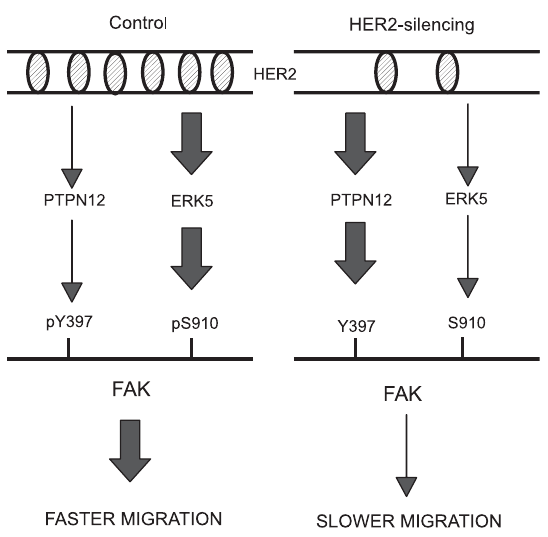
Fig. 6. Proposed contribution of PTPN12 and ERK5 to the HER2- directed cell migration. FAK phosphorylation at Y397 and S910 by PTPN12 and ERK5, in control and HER2-silenced SKOV-3 cells, and consequences on FAK activity and cell migration. The arrow thickness defines low (thin arrow) or high (thick arrow) enzyme